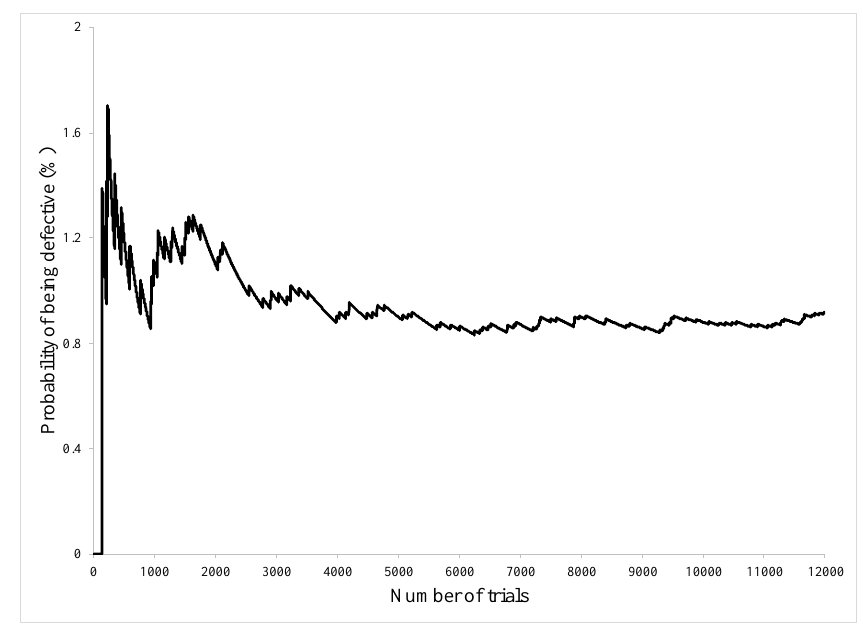
Figure 22. Defectiveness probability for the inspected rebar based on the Monte Carlo simulation method.